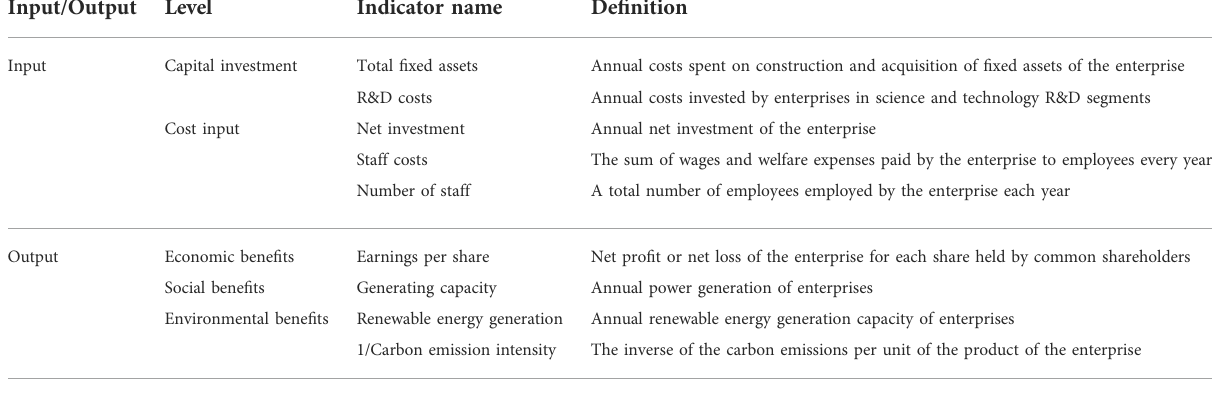
TABLE 2 Primary evaluation index system of energy Internet investment and merger ef fi ciency of power enterprises.